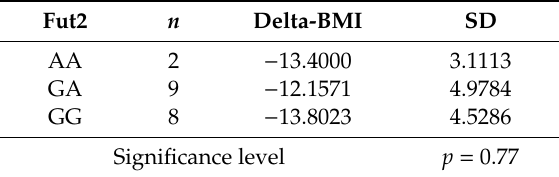
Figure 3. Weight reduction after bariatric surgery. Table 2. Δ BMI after surgery in case of FUT2 variants.